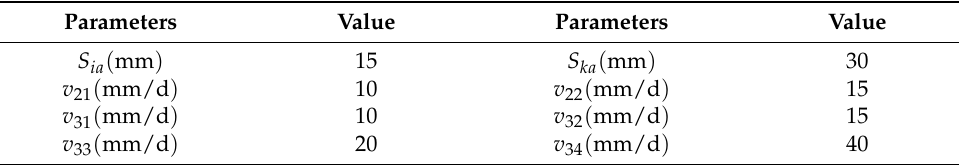
Table 3. Thresholds of the Zhongma landslide.